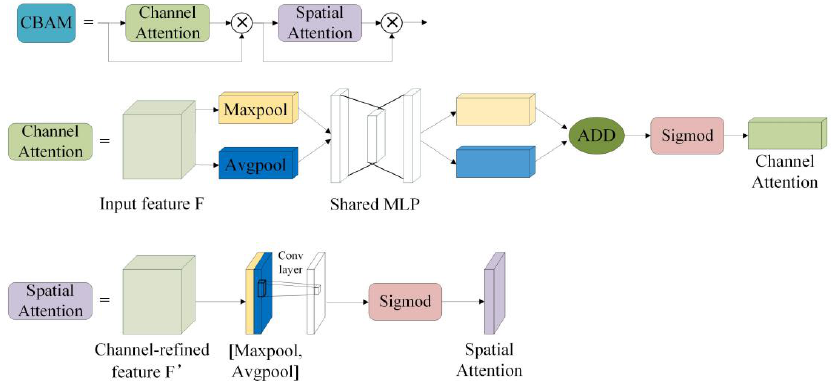
Figure 3. Structure of YOLO-V5s network.